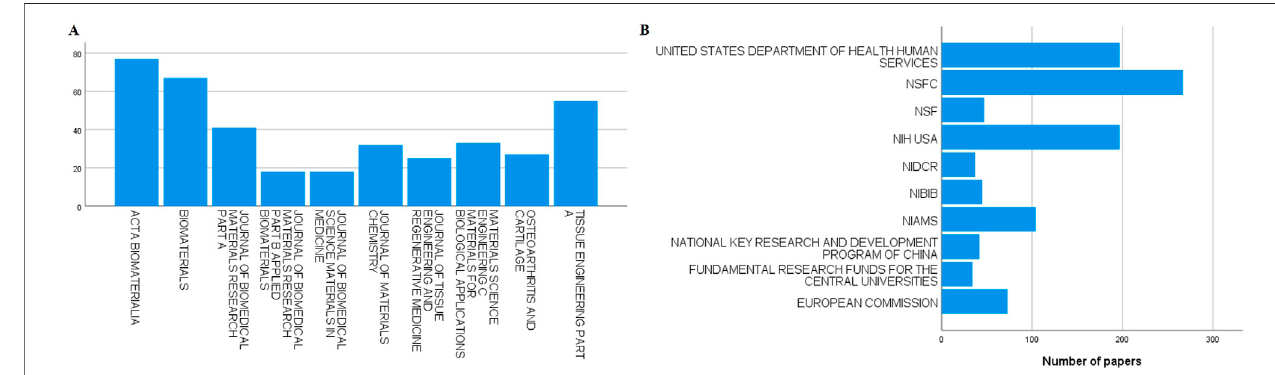
Figure5| Analysisofjournalsand fundingsagencyrelated toresearchesofhydrogelincartilagerepair. (A) Thenumberofpaperspublishedbythetop10journals. (B) Top 10 funding agency Contributing to the global research hydrogel in cartilage repair. NSFC, National Institute of Dental Carniofacial Research; NIBIB, National